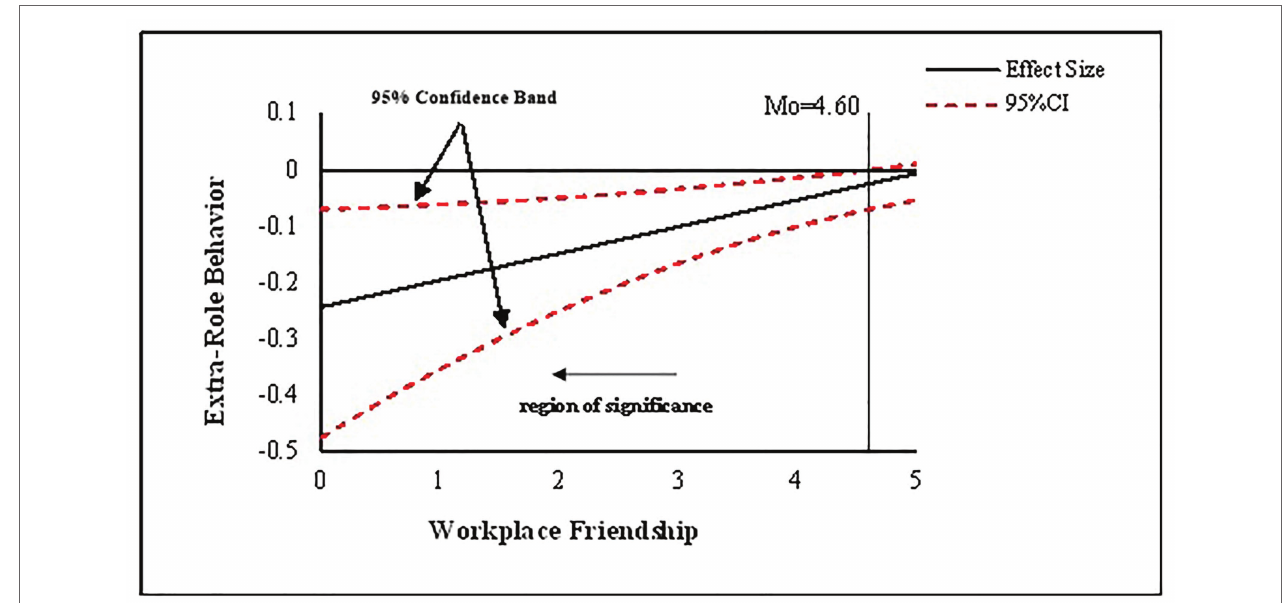
FIGURE 3 | The moderating effect of workplace friendships on the indirect relationship of job insecurity with extra-role behavior through negative